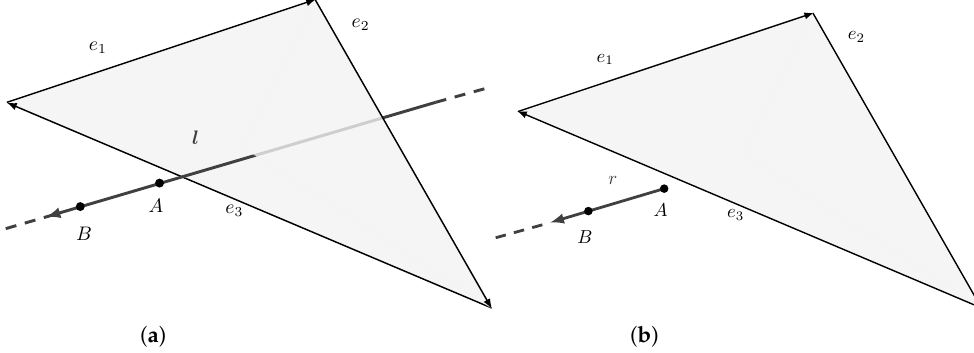
Figure 8. Comparison between line and ray intersection tests. ( a ) Considering the line passing through A and B , there is an intersection with the polygon. ( b ) Considering the ray starting in A and passing through B , there is no